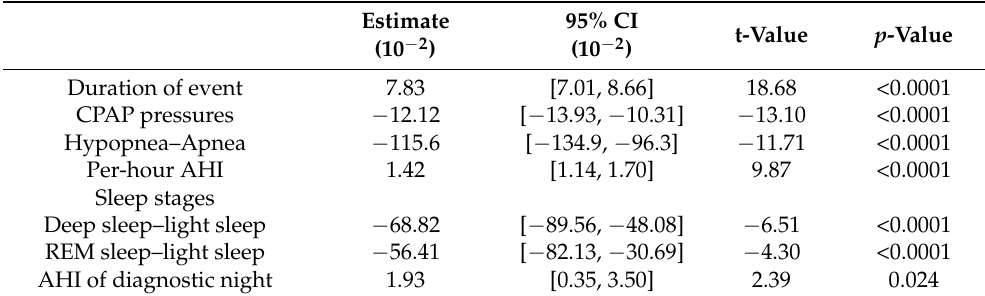
Table 2. The results of the linear mixed-effects model predicting the degree of oxygen desaturation measured at